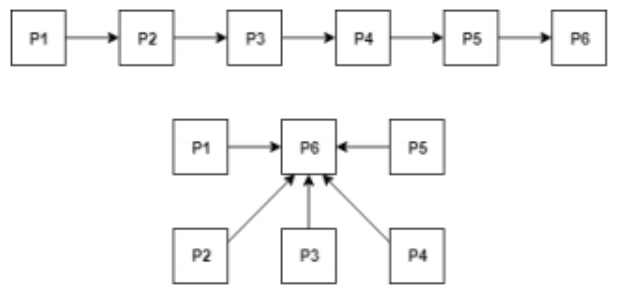
Figure 4. Skewed execution times